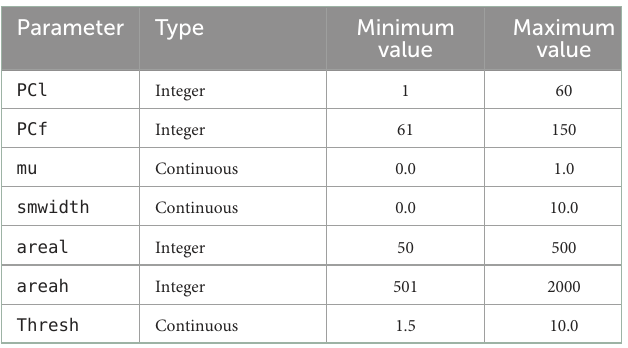
TABLE 6 Parameters in